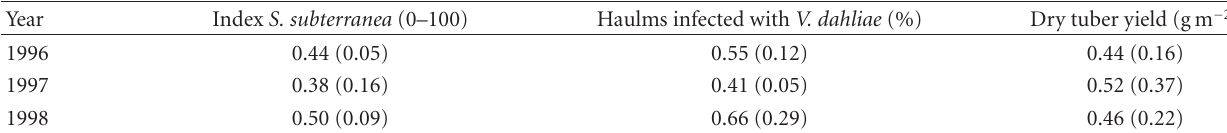
, and standard errors of (cid:10) β j , calculated with (11)–(13) for S. j